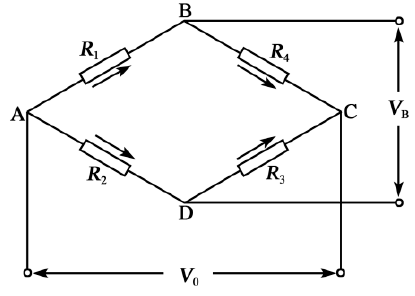
Figure 1. Schematic diagram of silicon piezoresistive pressure sensor.